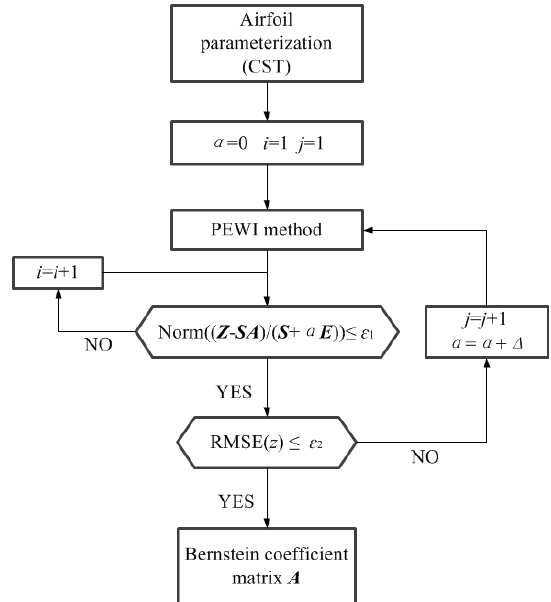
Figure 1. Iterative process of the pivot element weighting iterative method. RMSE: root mean square error; CST: class function/shape function transformation method.